Question: What does this figure show? Answer in one sentence.
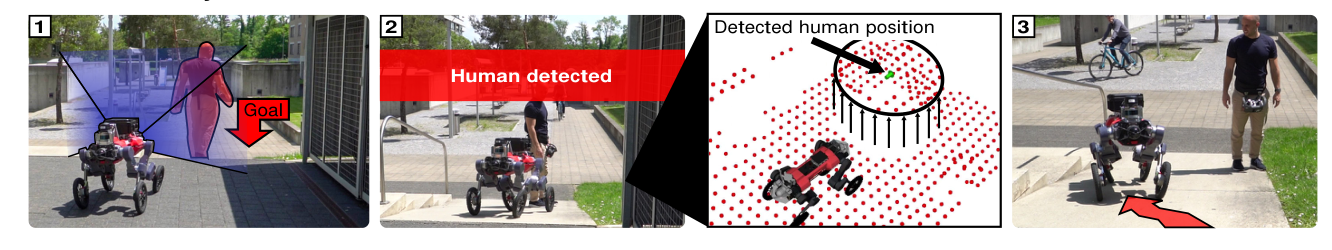
Answer: Obstacle negotiation. (A) Our robot navigates around blocked routes by actively exploring the area and finding alternative paths. (B) Safe traversal of a narrow space. (C) Our robot exhibits two different ways to traverse the complex obstacle. (C, D) Our robot shows an asym- metric understanding of traversability, being able to traverse higher steps when going down. (D) We ensure safety around humans by incorporat- ing additional human detection and overriding height scan values.